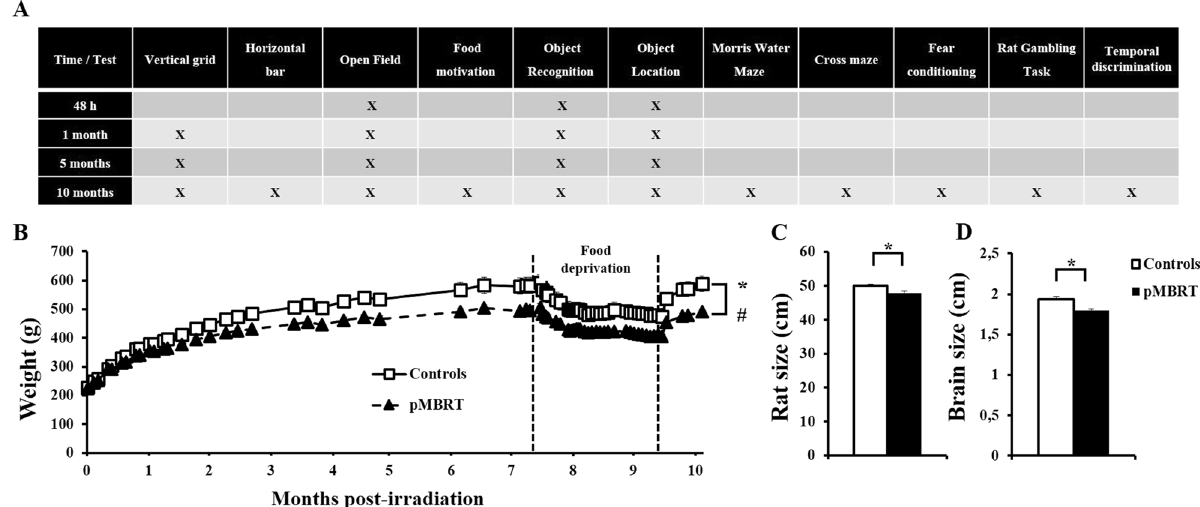
Figure 1. Morphological measurements. General overview of the behavioural tasks ( A ). Irradiated rats were lighter than control rats as a function of days post-irradiation (PI) ( B ). pMBRT rats had smaller bodies ( C ) and brains ( D ) than control animals at 10 months PI. The data are presented as the mean ± SEM; *p < 0.05; #: group × month